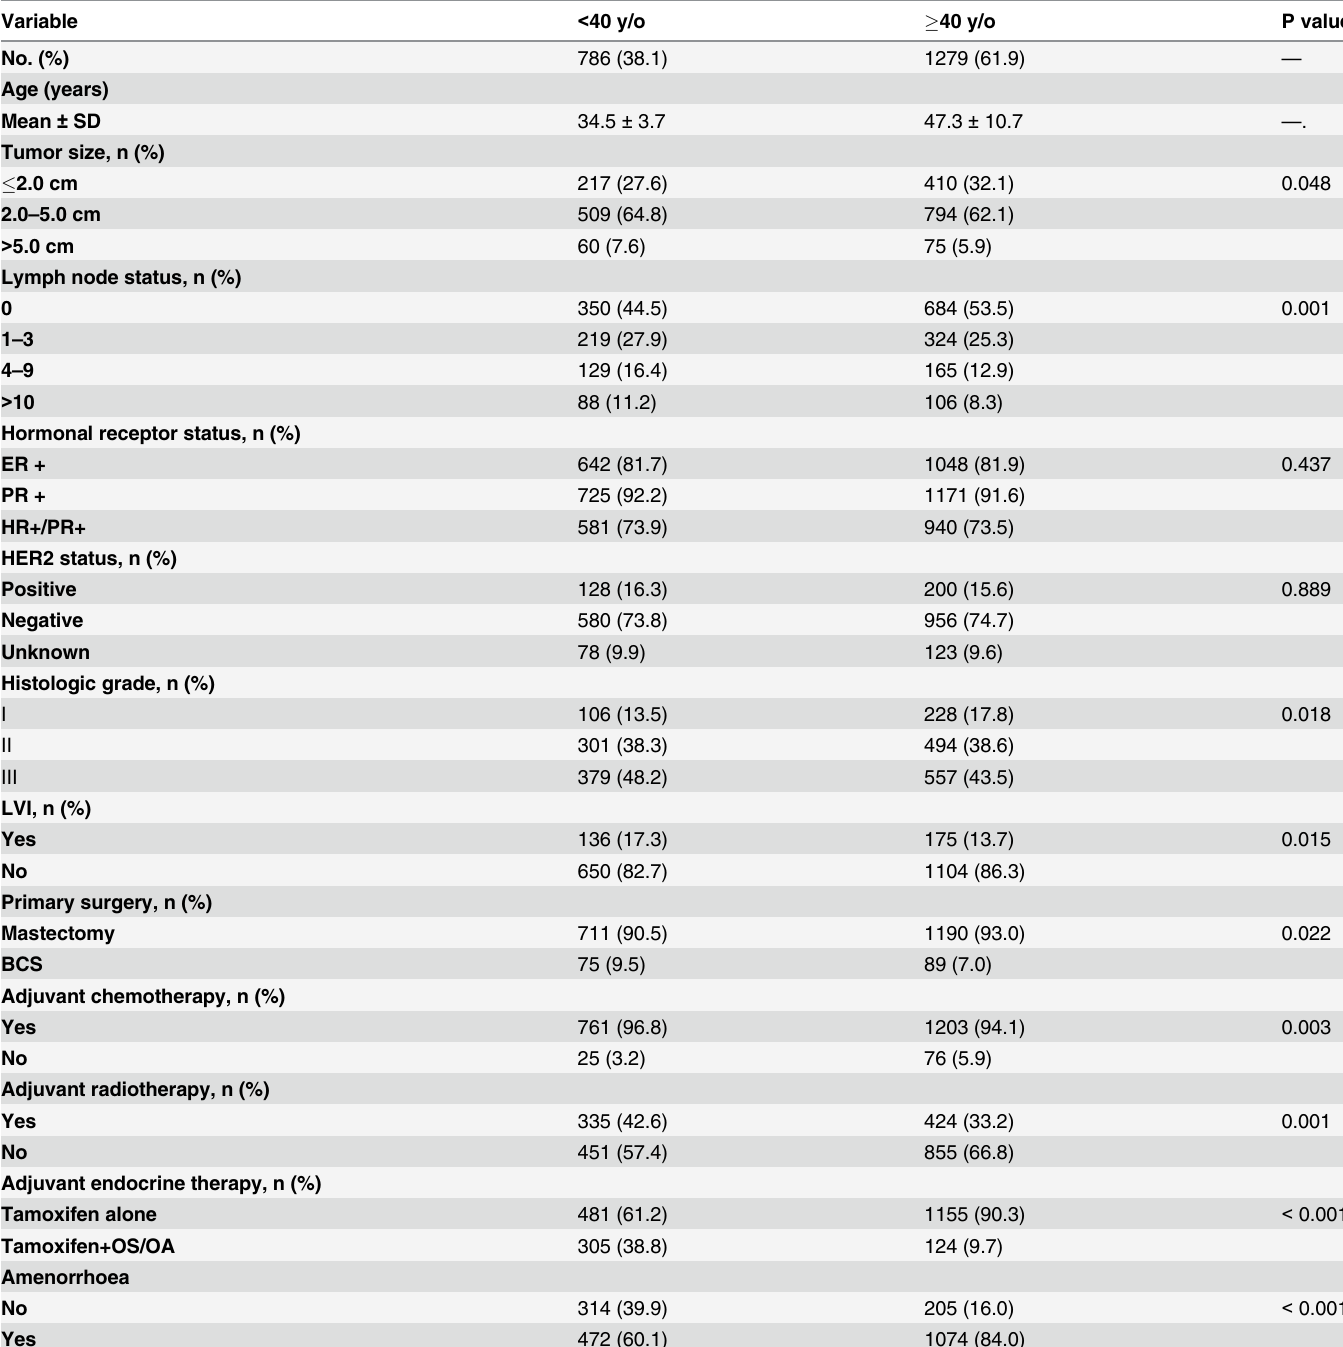
Table 1. Clinical characteristics and treatment of different age-specific